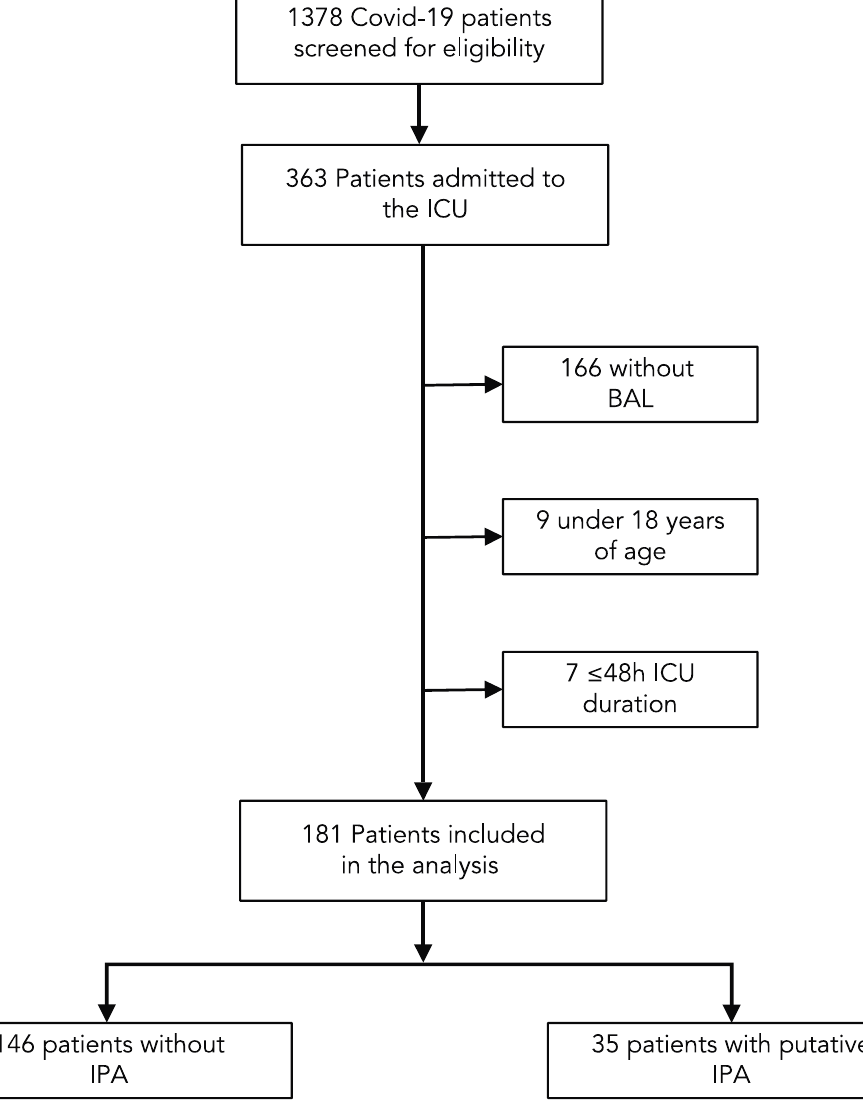
Figure 1. Flow chart of the study population.